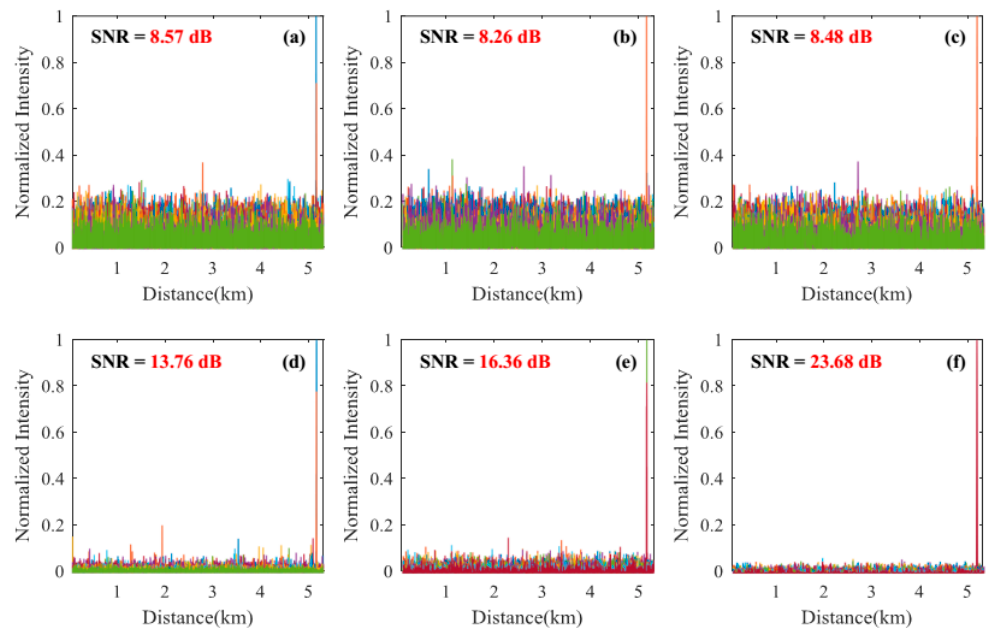
Figure 4. The locating results of pencil-break vibration under 100 ns pulse width. ( a ) The result of moving average and differential (MAD) method; ( b ) The result of two-dimensional edge detection (TED) method; ( c ) The result of multi-scale wavelet decomposition (MWD) method; ( d ) The result of wavelet denoising (WD) method; ( e ) The result of SK method; ( f ) The result of SAK method. SNR: signal-to-noise ratio.